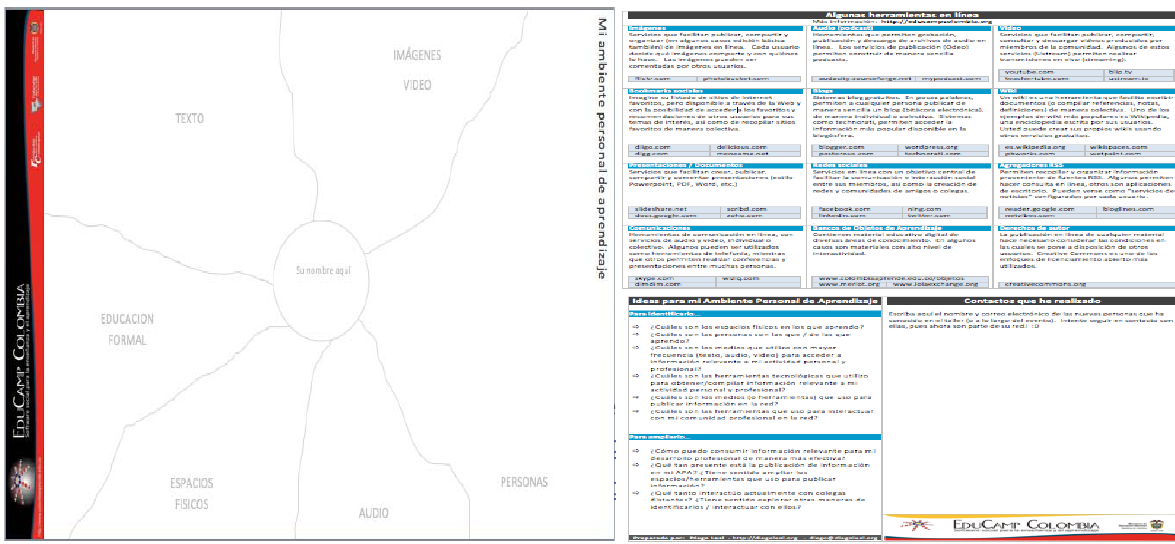
Figure 1 . Facsimile of the PLE outline and the tool sheet (available in Spanish at